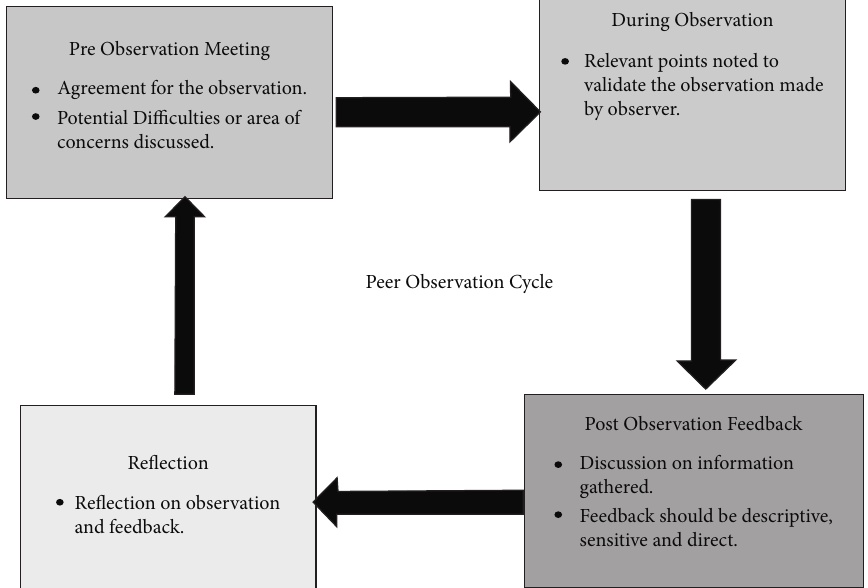
Figure 1: Peer observation cycle. Peer observation cycle occurs in multiple steps that mainly include preobservation meeting, observation, postobservation feedback, and